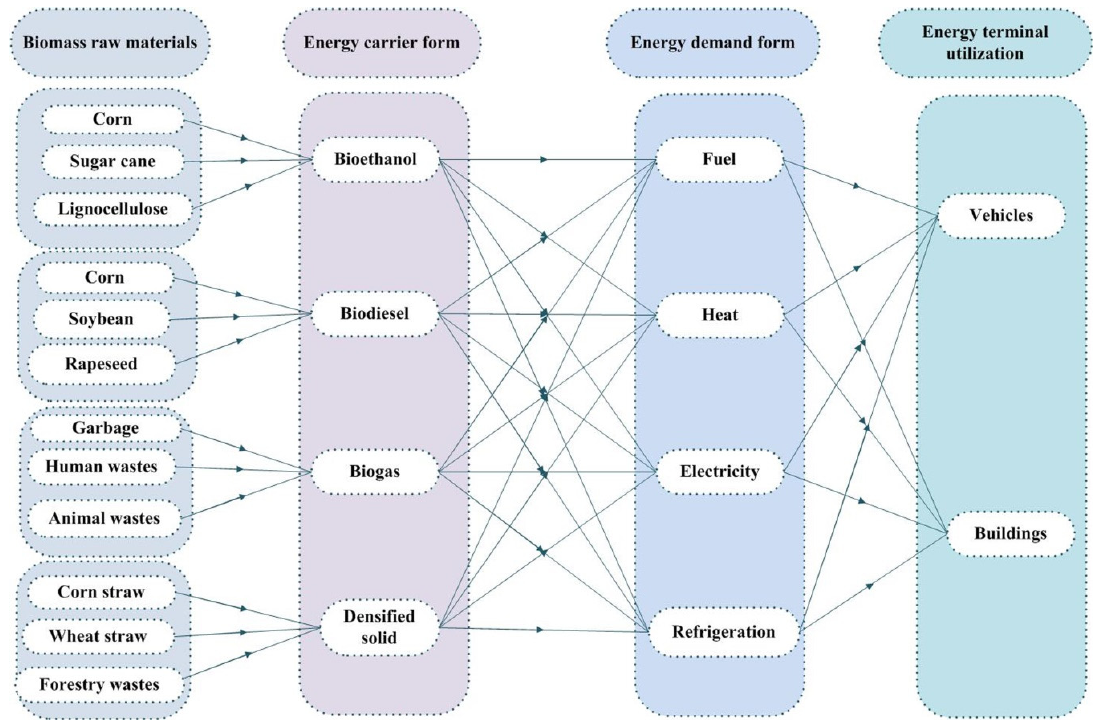
Figure 2. The technology roadmap of bioenergy: from biomass raw materials to final energy use [27].